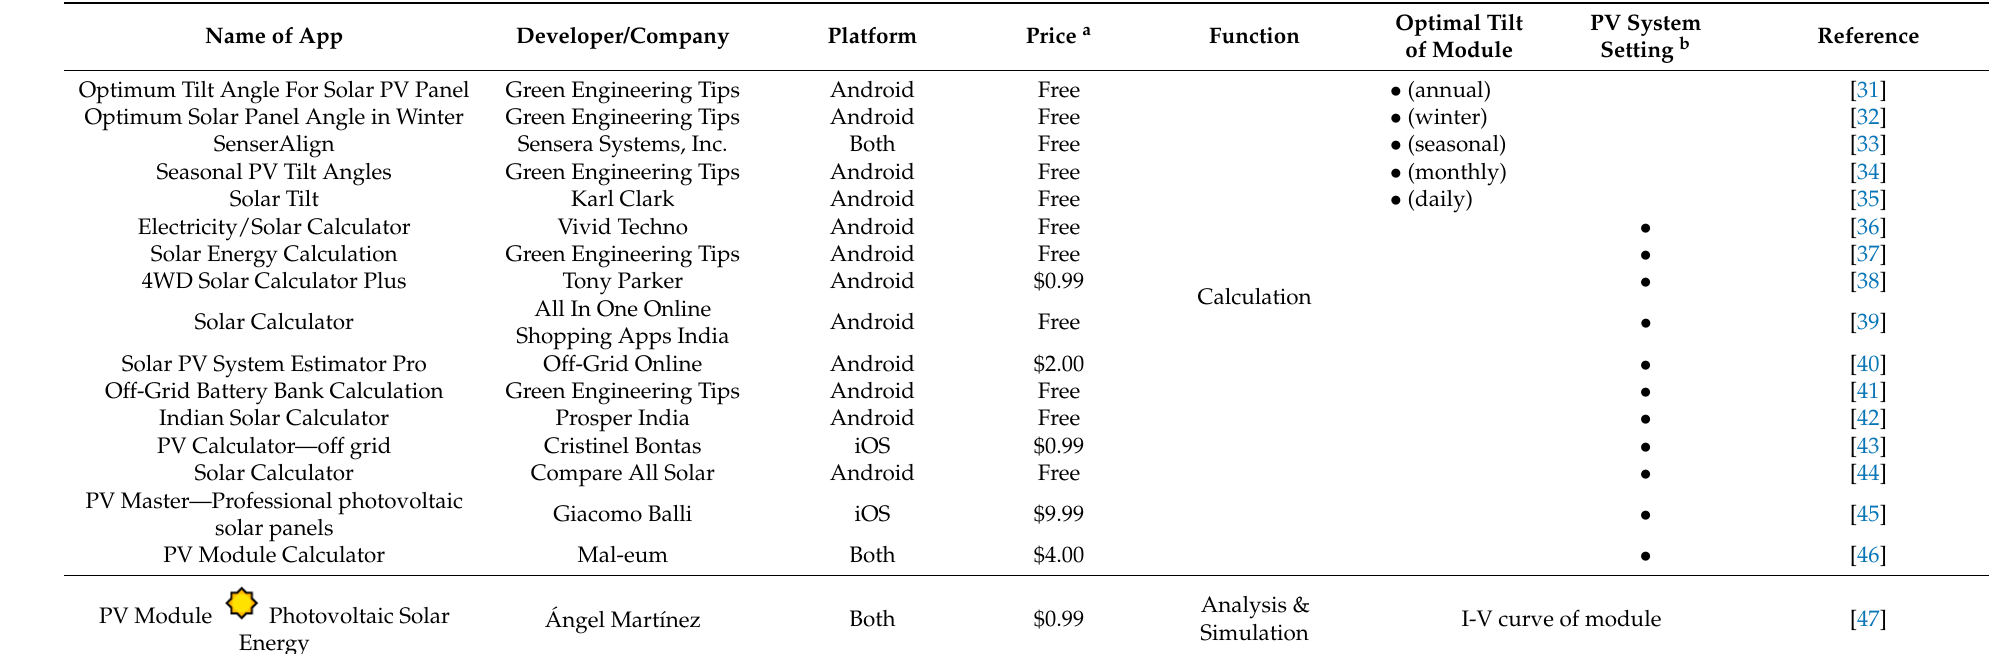
Table 4. Summary of smartphone applications on PV system optimal